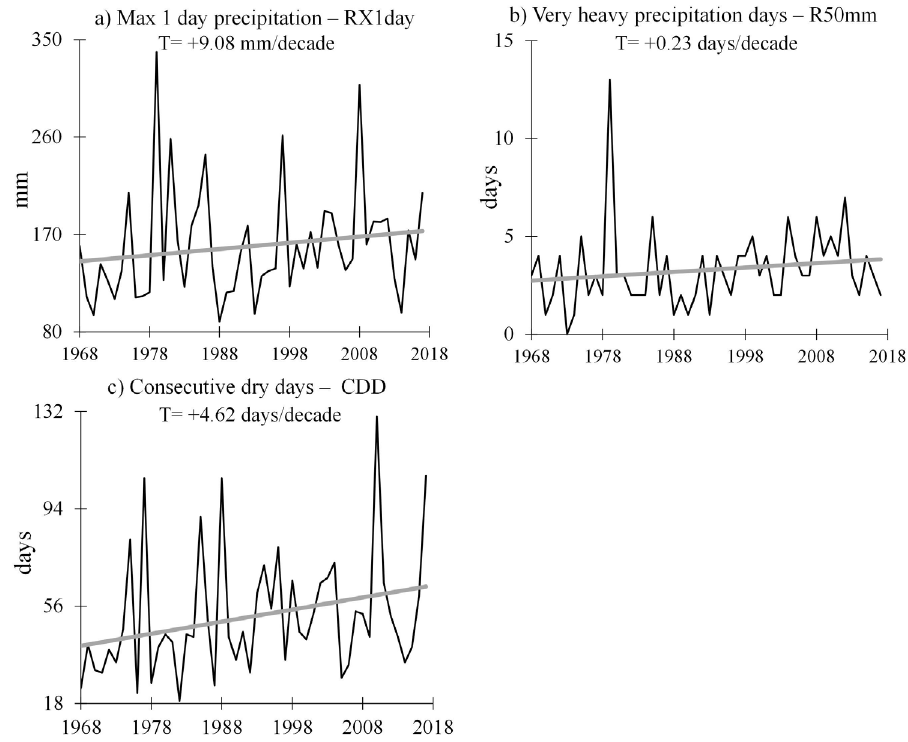
Figure 8. Temporal distribution of the extreme precipitation indices in the 1968–2017 period for the annual scale. Index with a gray line indicates significant linear trend (Table III), at least at the 95% confidence